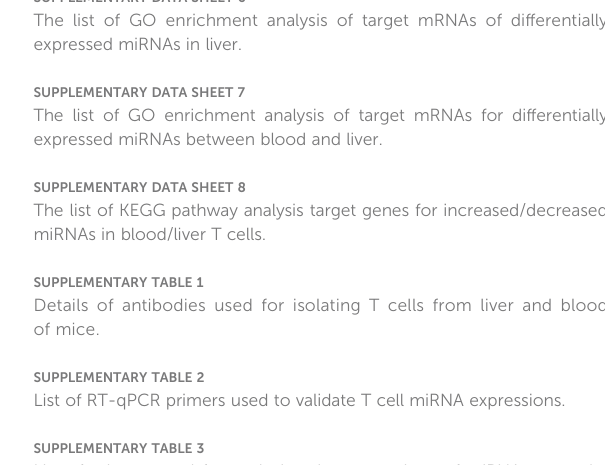
List of RT-qPCR primers used to validate T cell miRNA expressions.